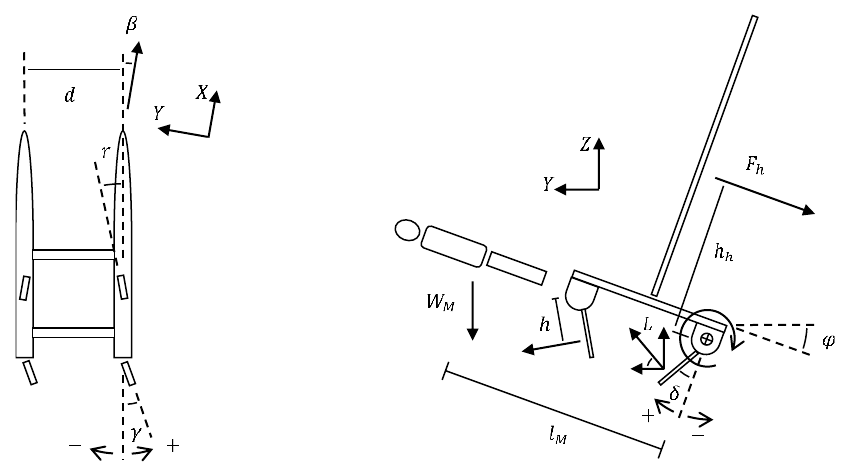
Figure 1. Scheme of forces acting on the boat.